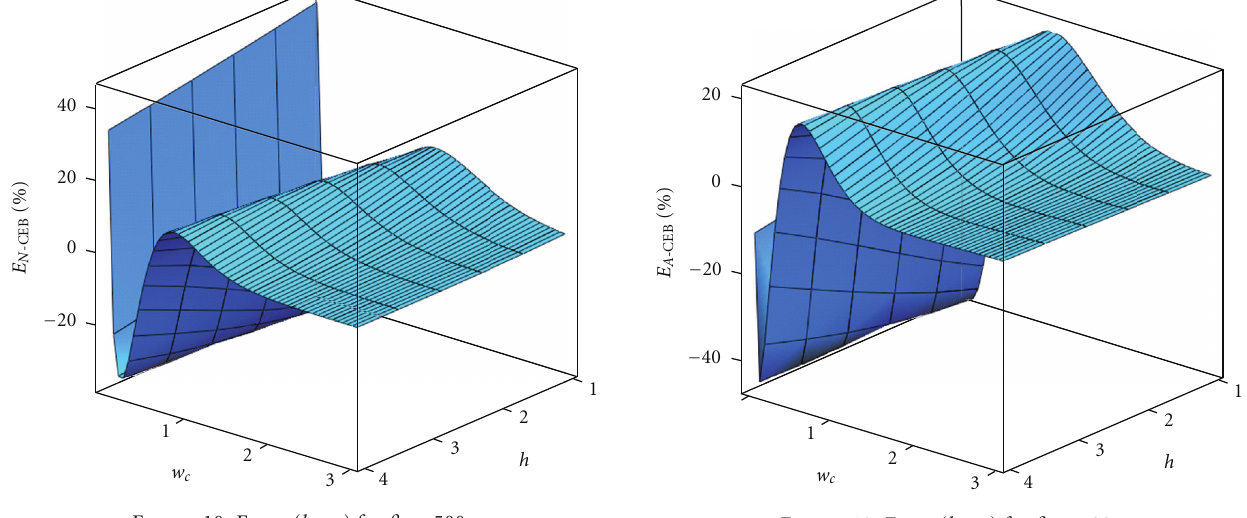
Figure 12: E A -CEB ( h , w c ) for β s =